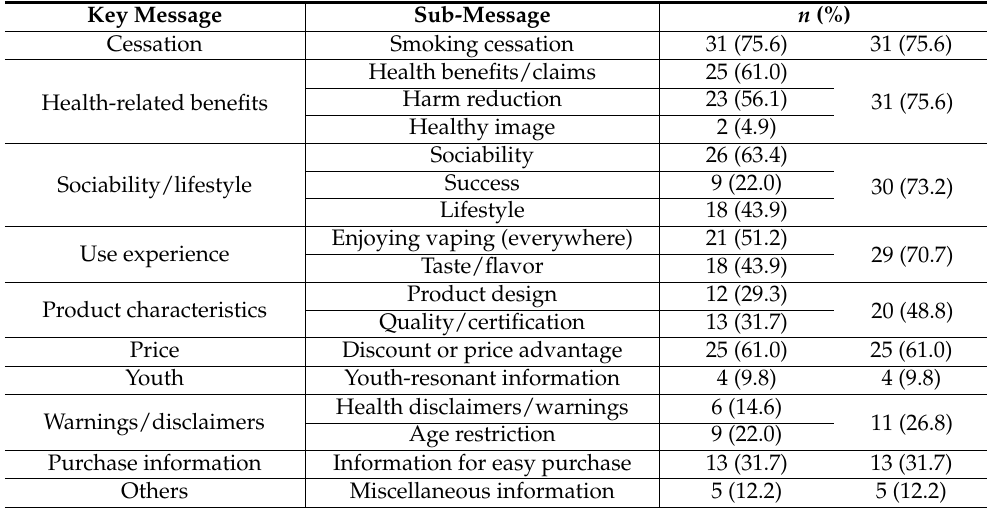
Table 1. Frequency of marketing communication messages reported in published studies ( n =